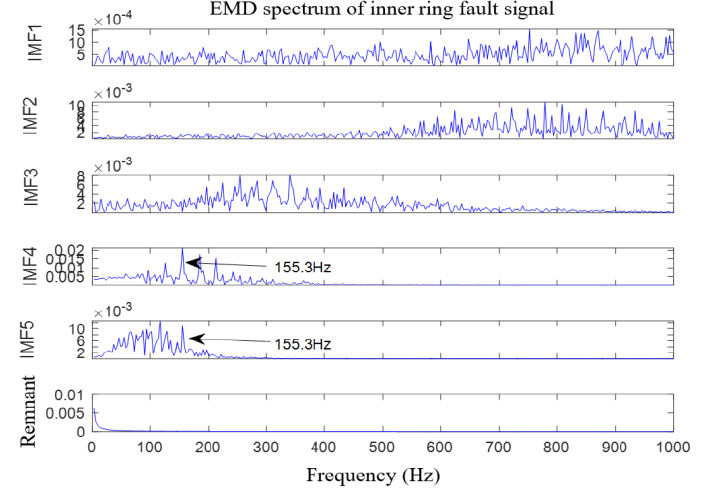
Figure 19. The processing results of inner ring fault signal.